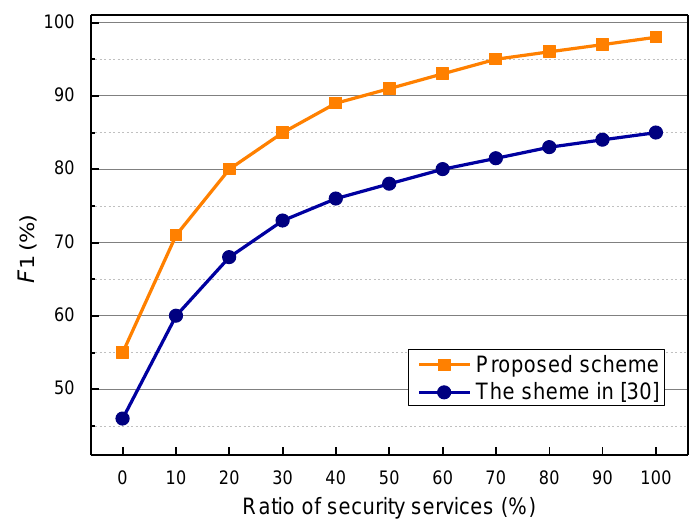
Figure 6. F 1-measure of service recommendation.